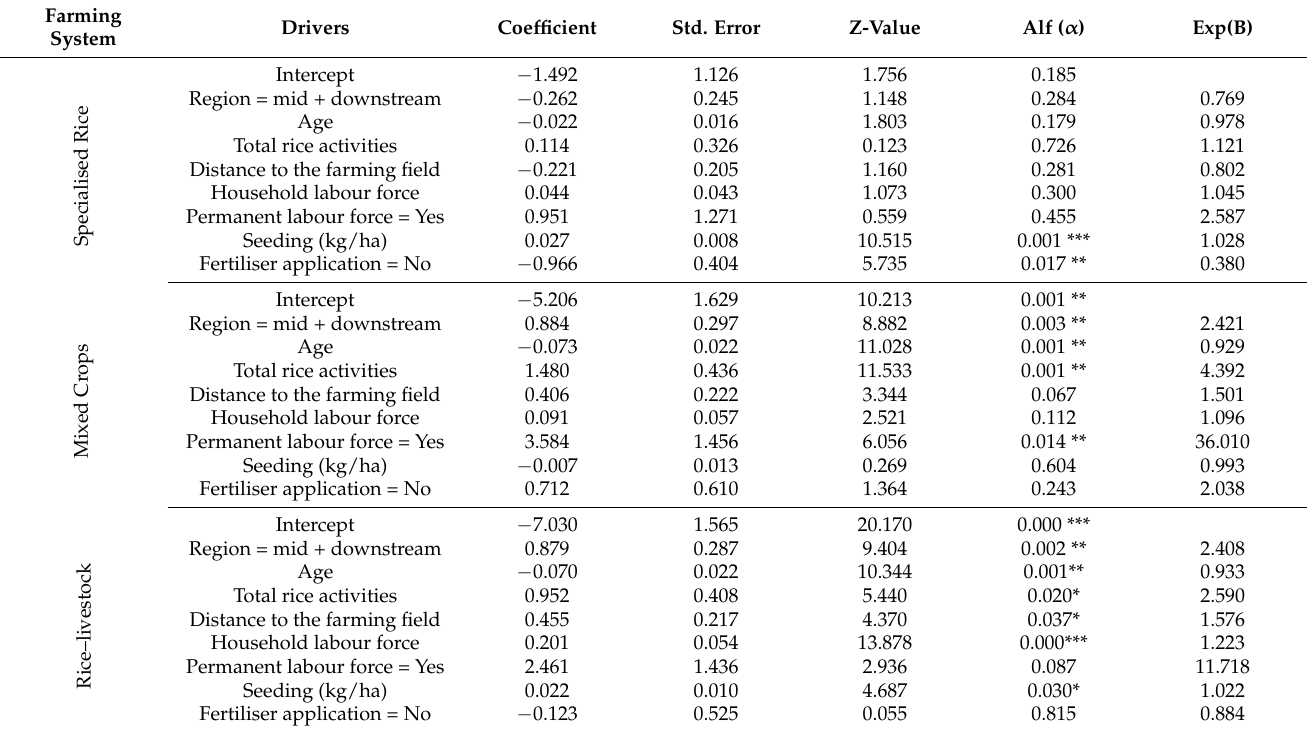
Table 5. Multinomial logistic model of farming system choice and its drivers/determinants. Farming